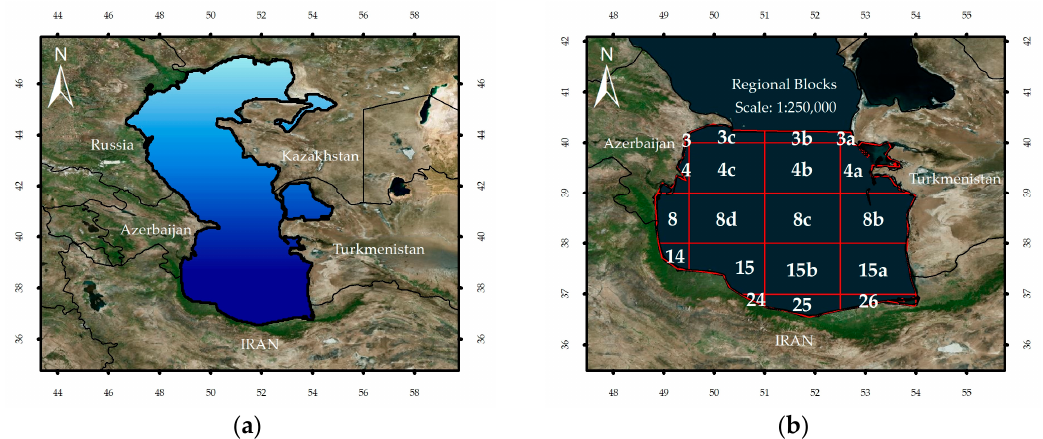
Figure 1. ( a ) Spatial position of the Caspian Sea (CS) and ( b ) The spatial subsetting of the Southern Caspian Sea (SCS) based on Iran’s National Cartographic Center guidelines. The temporal variability in bio-optical properties is communicated for each block.